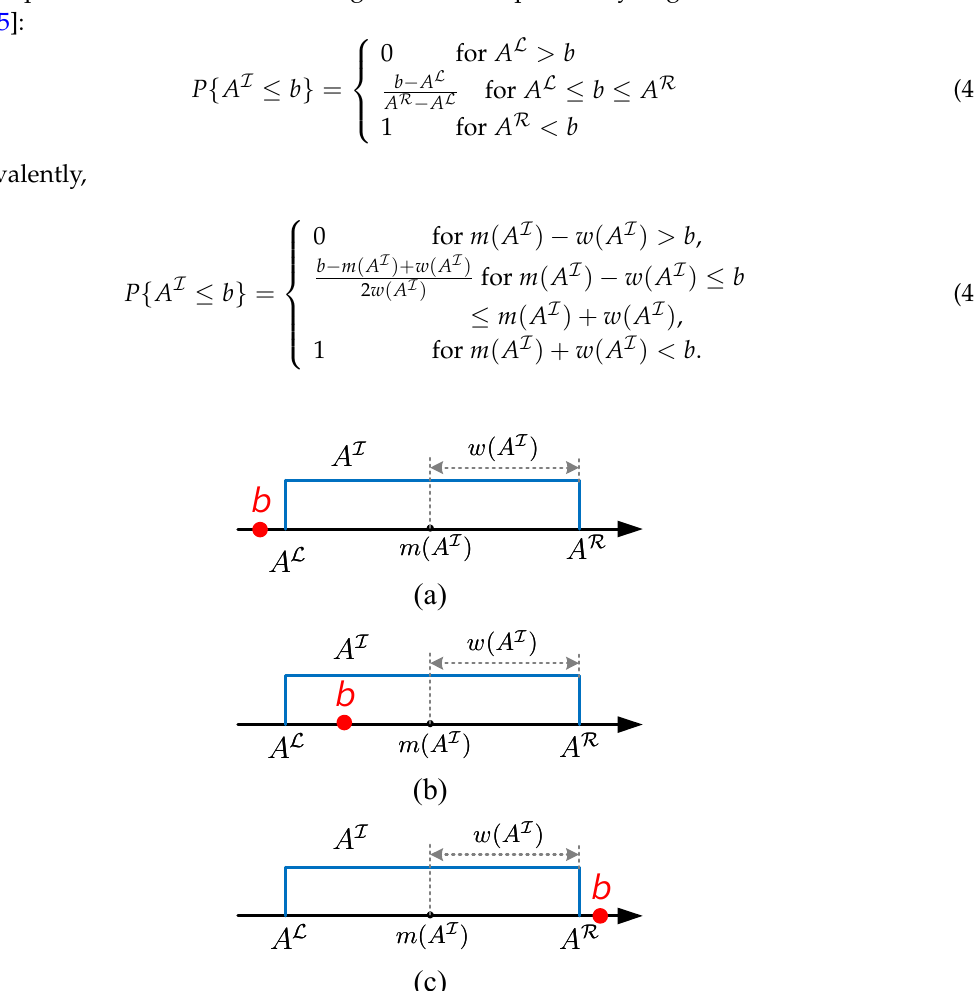
Figure 2. Relation between an interval and a real number. ( a ) A L ≥ b ; ( b ) A L ≤ b ≤ A R ; ( c ) A R ≤ b